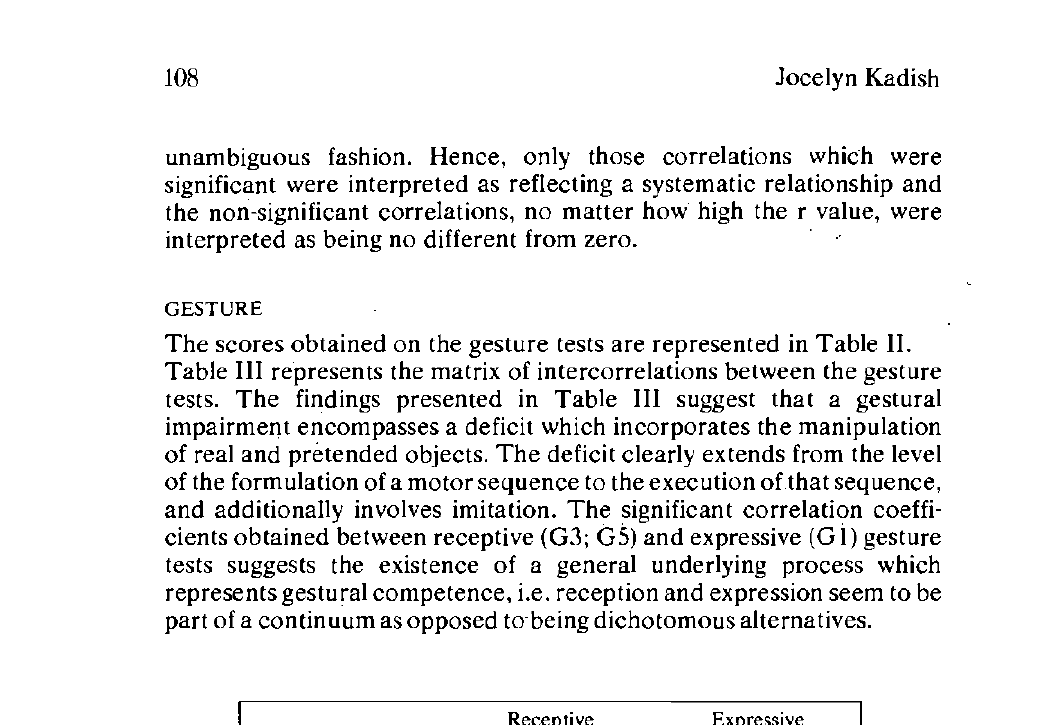
TABLE II. Scores Obtained on Receptive and Expressive Gesture Tests for all Ss.